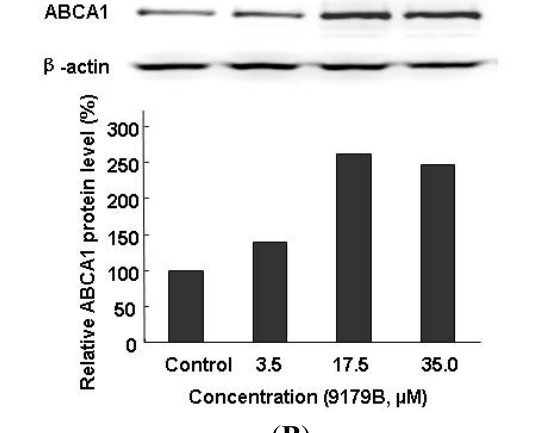
Figure 3. The effects of 9179B on the expression of ABCA1 in HepG2 and RAW 264.7 cells and on cholesterol efflux in RAW 264.7